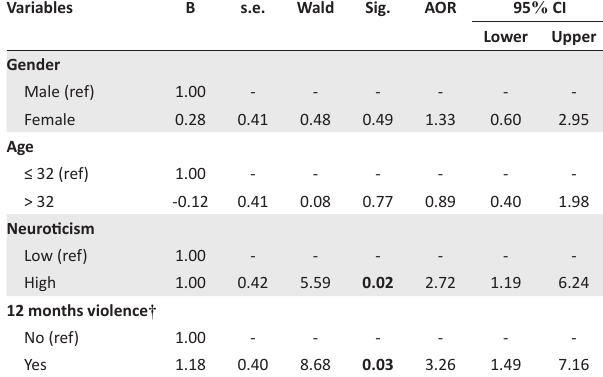
AOR, adjusted odds ratio; CI, confidence interval; s.e., standard error. Significant test of association in bold . Degree of freedom ( df ) = 1. † , Violence by patients.